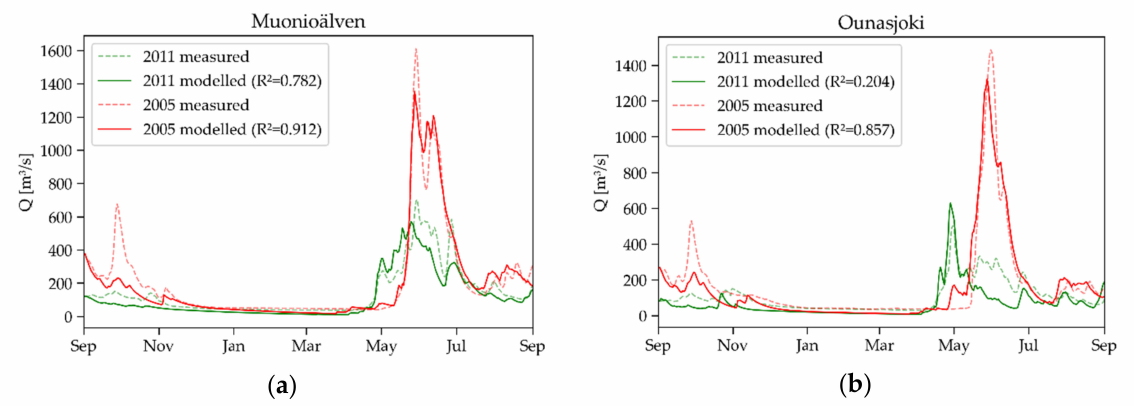
Figure 14. SRM results for the maximum and minimum peak discharge of ( a ) Muonioälven and ( b ) Ounasjoki.